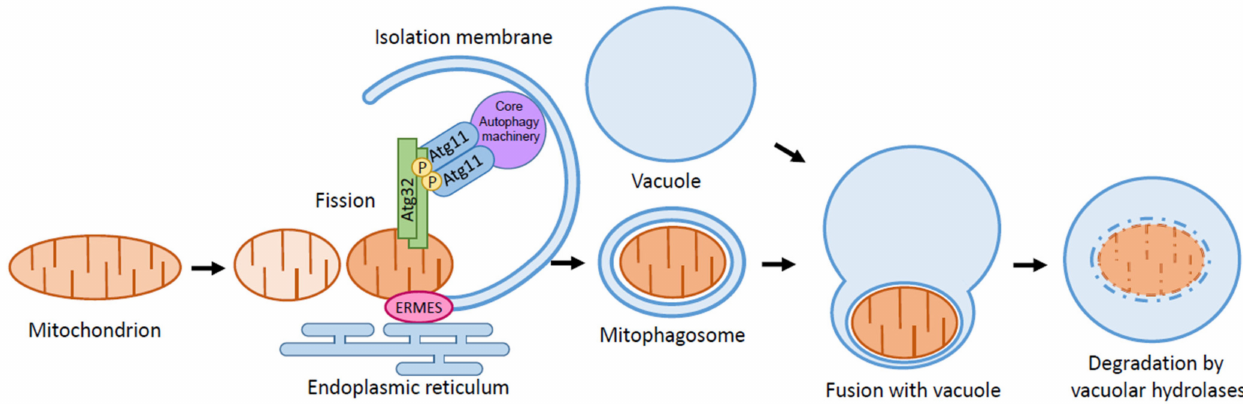
Figure 1. Schematic depiction of mitophagy. Mitophagy is a type of selective autophagy. Upon mitophagy induction, the mitophagy receptor Atg32 interacts with the adaptor protein Atg11. Atg11 then tethers the mitochondria to the PAS for selective sequestration by the isolation membrane. ERMES helps in expanding the isolation membrane to provide lipid sources from ER. Further extension of the isolation membrane leads to the formation of the mitophagosome, eventually fusing with the vacuole for the degradation of the mitochondria by vacuolar